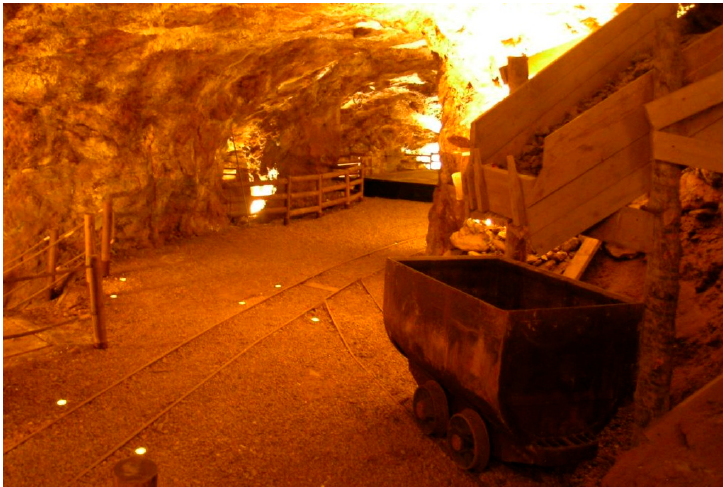
Figure 7. Inside the Agrupa Vicenta mine. Municipality of La Unión. Source: La Unión Mining Park [28].